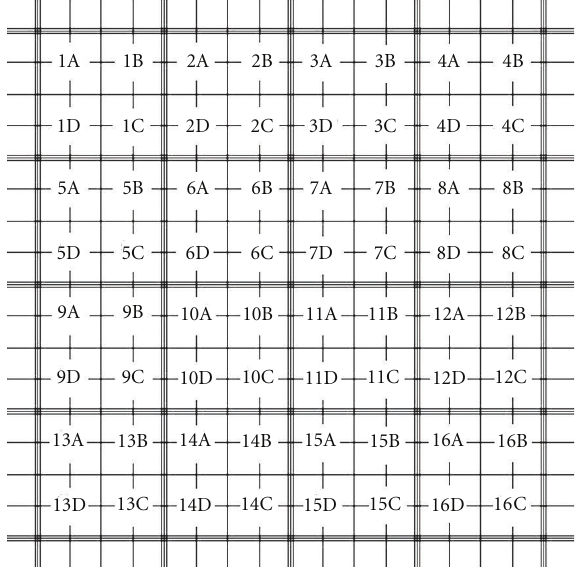
Figure 1: Orientation diagram for the acquisition of